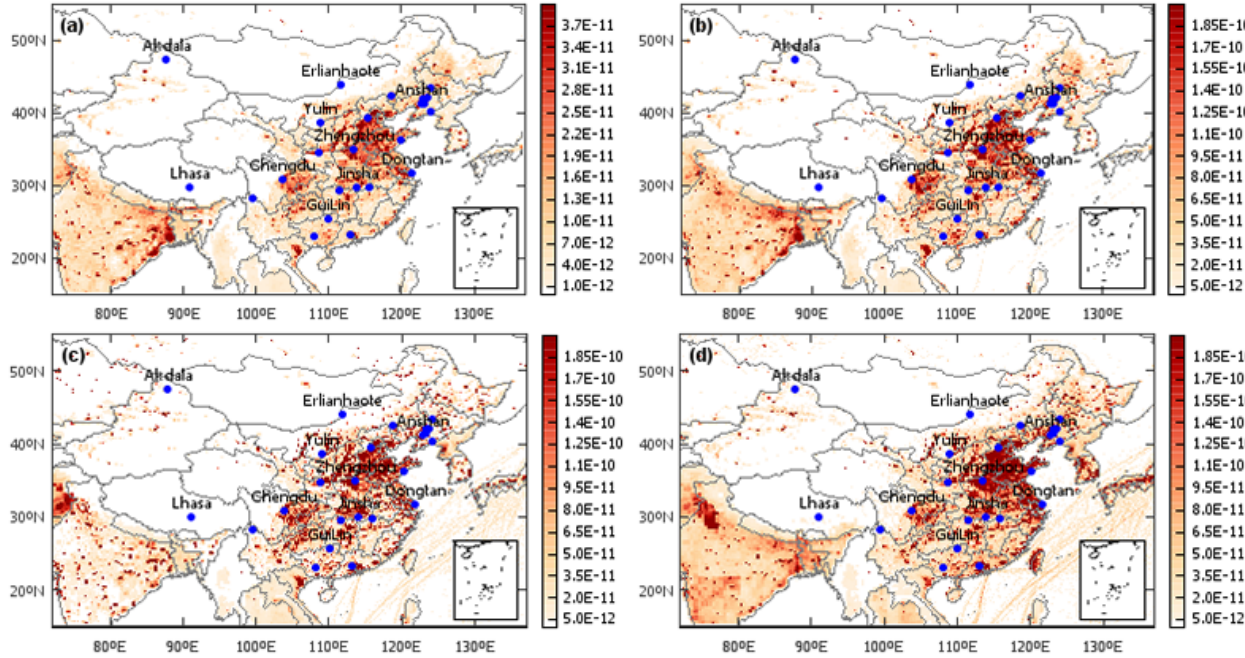
Figure 8. Anthropogenic emission distributions at a resolution of 0 . 1 ◦ × 0 . 1 ◦ , based on HTAP_v2 data set: (a) BC; (b) PM 2 . 5 ; (c) SO 2 ; (d) NO x (units: kgm − 2 s − 2